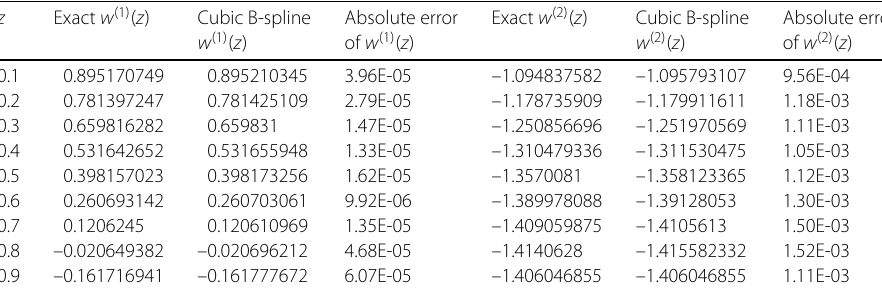
Table 16 Estimated derivative at the knots for Problem